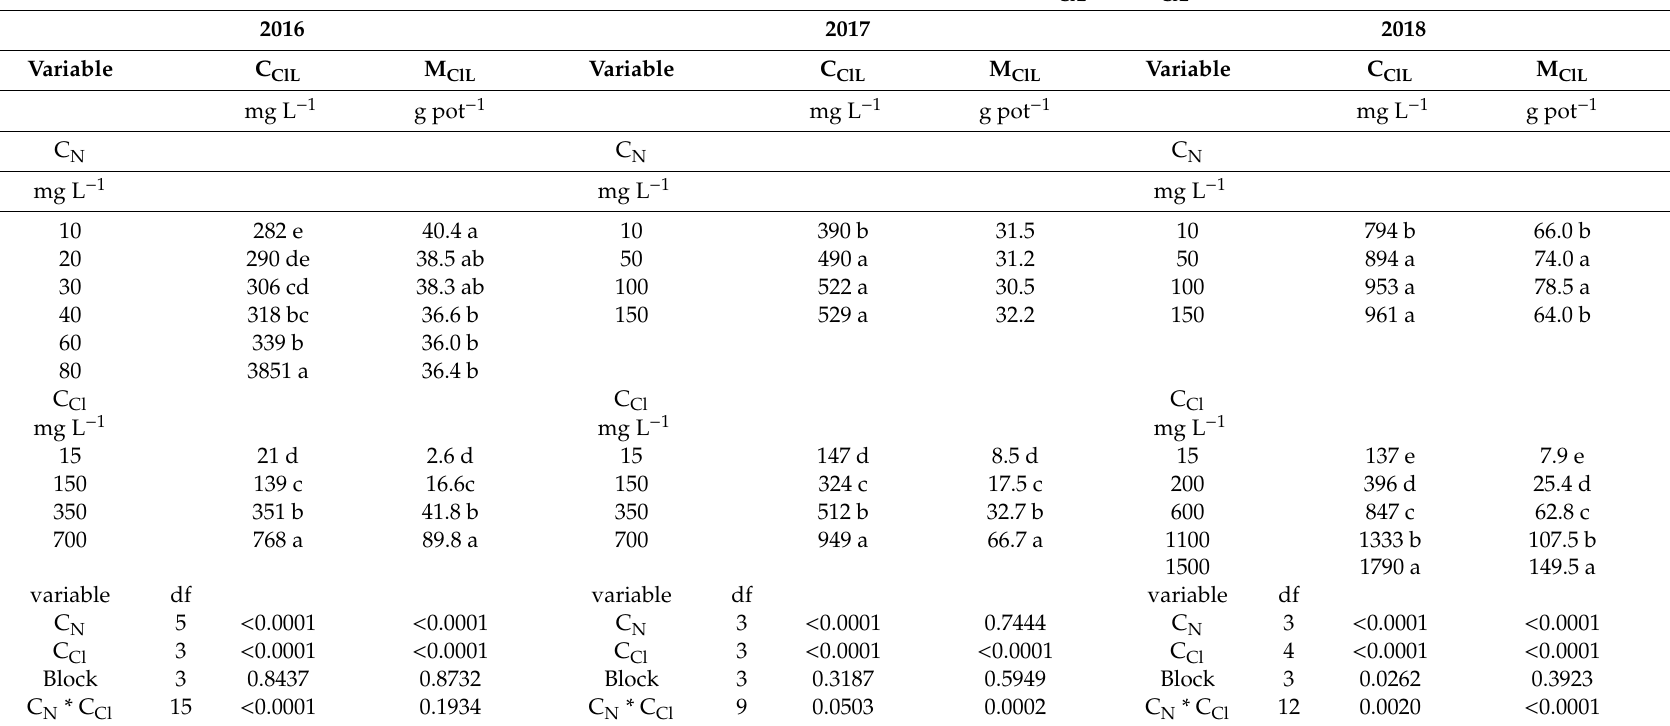
(b) The Concentrations and Mass of Cl in the Leachate (C ClL and M ClL